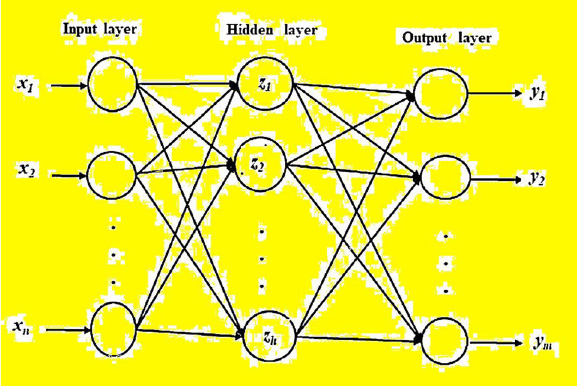
Figure 1. The general architecture of the ANN